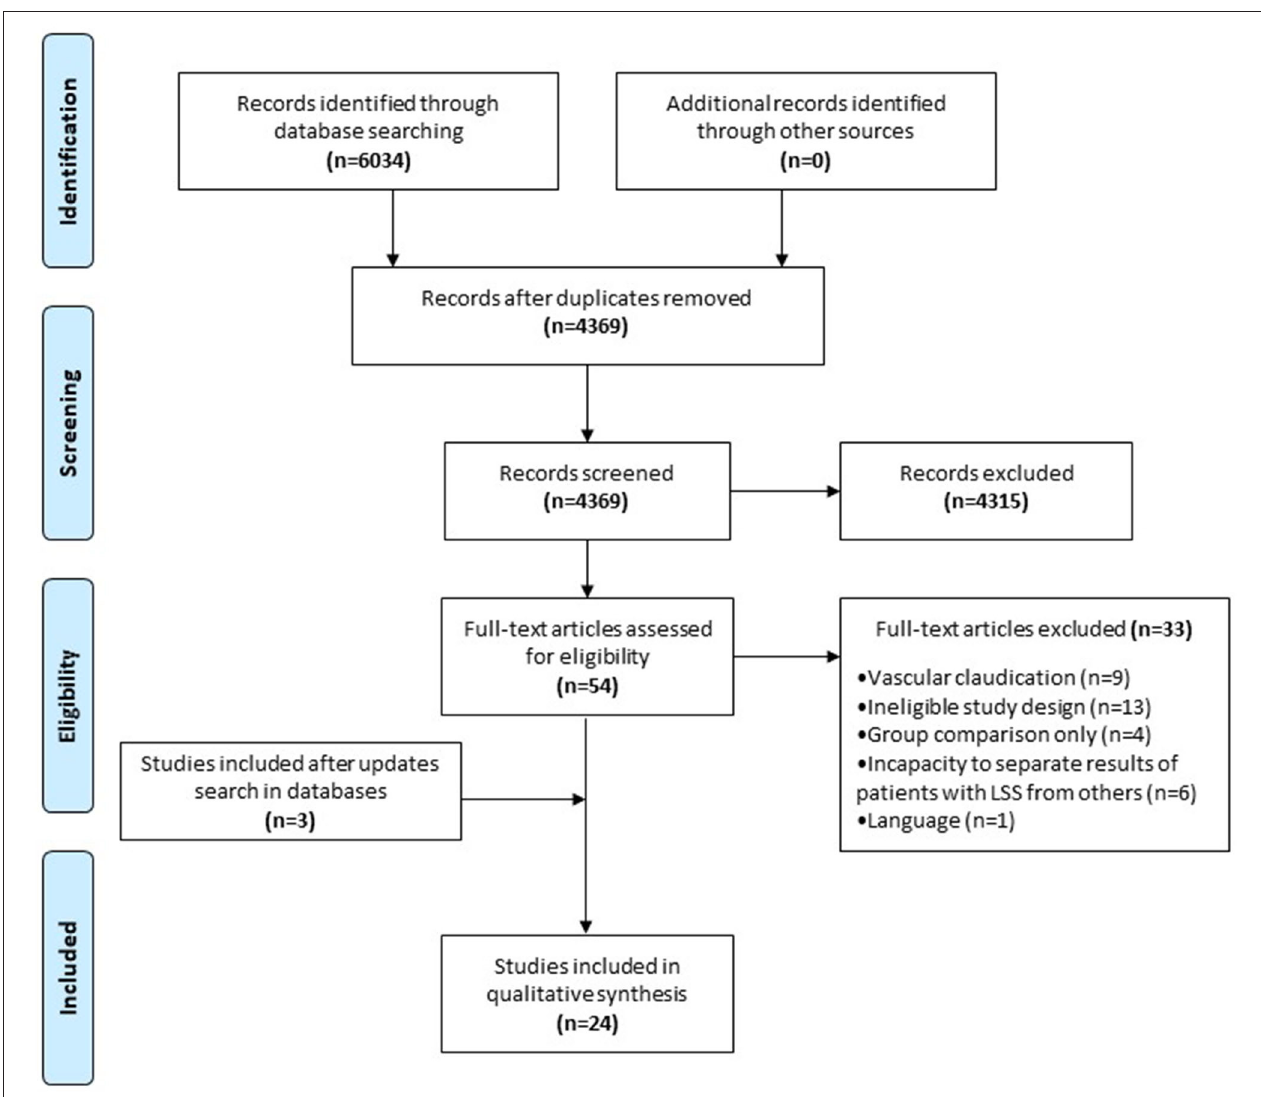
FIGURE 1 | PRISMA